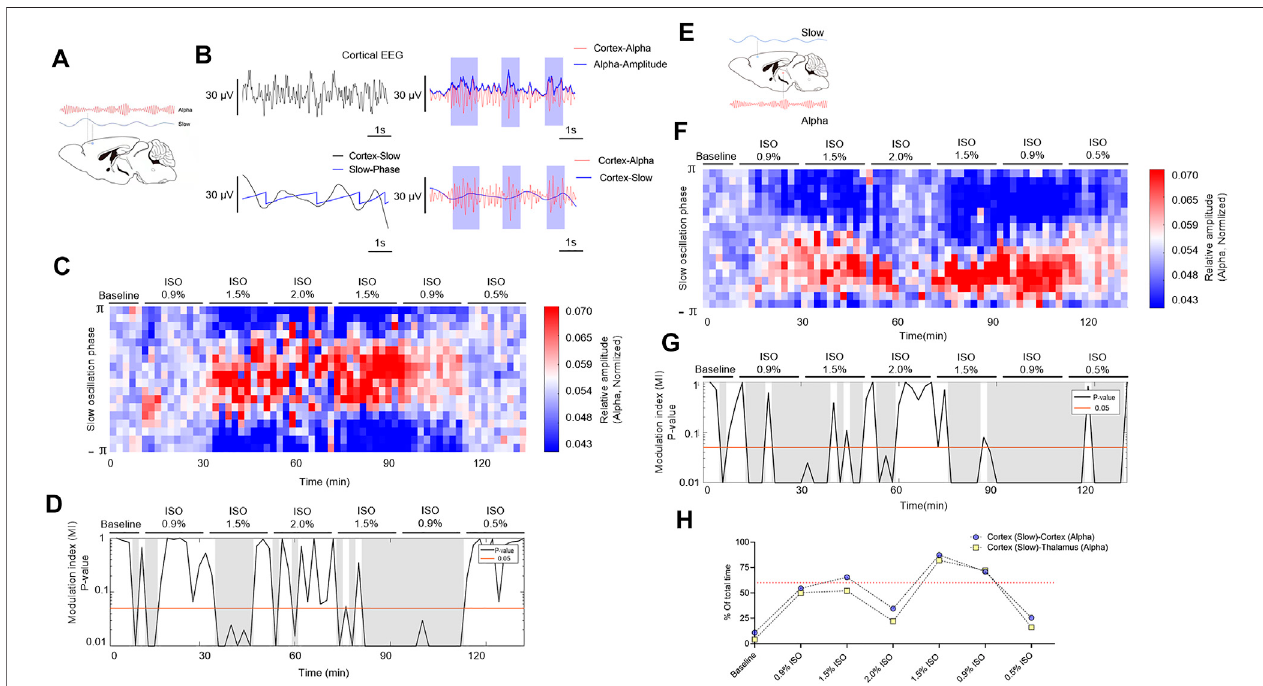
FIGURE5| PAC incortex and thalamocorticalnetworks. (A) Schematic cortex slow (blueline)and cortexalpha (redline) oscillations. (B) A sampleofPAC analysis process. (C) The phase – amplitude histogram showing the relationship between the cortical slow phase (y-axis) and cortical alpha amplitude (color map). (D) p -Value of the modulation index (MI), determined by a shuf fl e control procedure; gray shading indicates statistically signi fi cant ( p < 0.05) epochs. (E) Schematic of PAC between cortex slow (blue line) and thalamic alpha (red line). (F) The phase – amplitude histogram showing the relationship between the cortical slow phase (y-axis) and thalamic alpha amplitude (color map). (G) p -Value of the modulation index, determined by a shuf fl e control procedure; gray shading indicates statistically signi fi cant ( p < 0.05) epochs. (H) The total proportions of gray shadings (D,G) of all subjects. The dotted line shows the proportions at 60%. PAC, phase – amplitude coupling; and ISO, iso fl